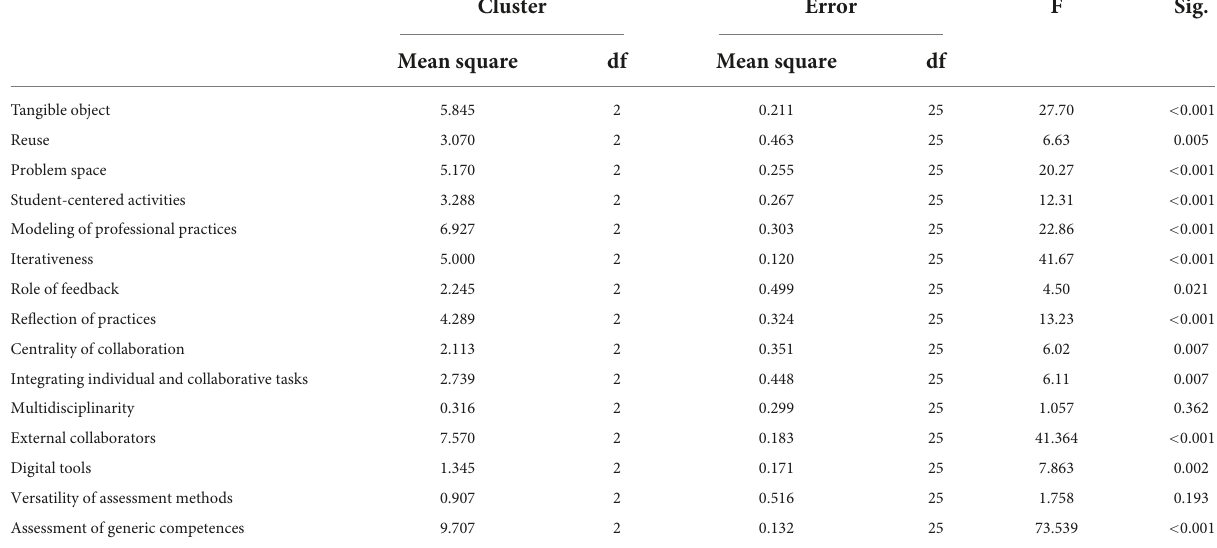
TABLE 5 Pedagogical practices cluster analysis descriptors.